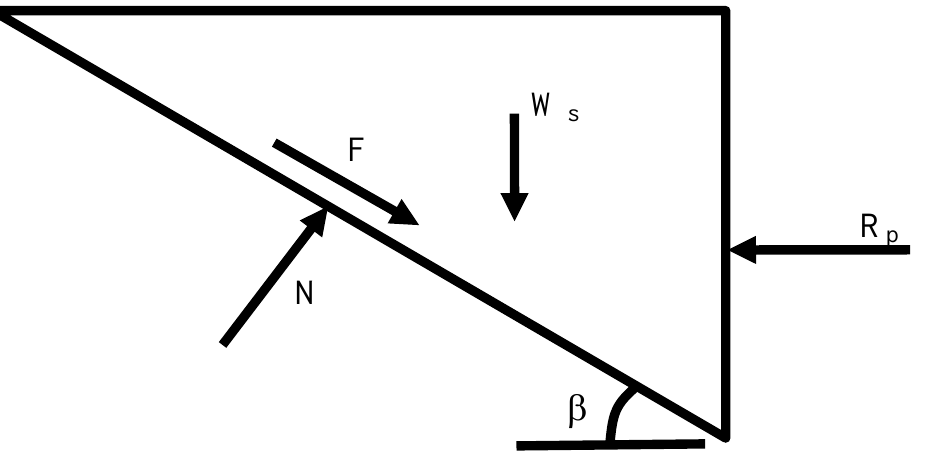
Figure 16. Free body diagram of passive soil wedge against